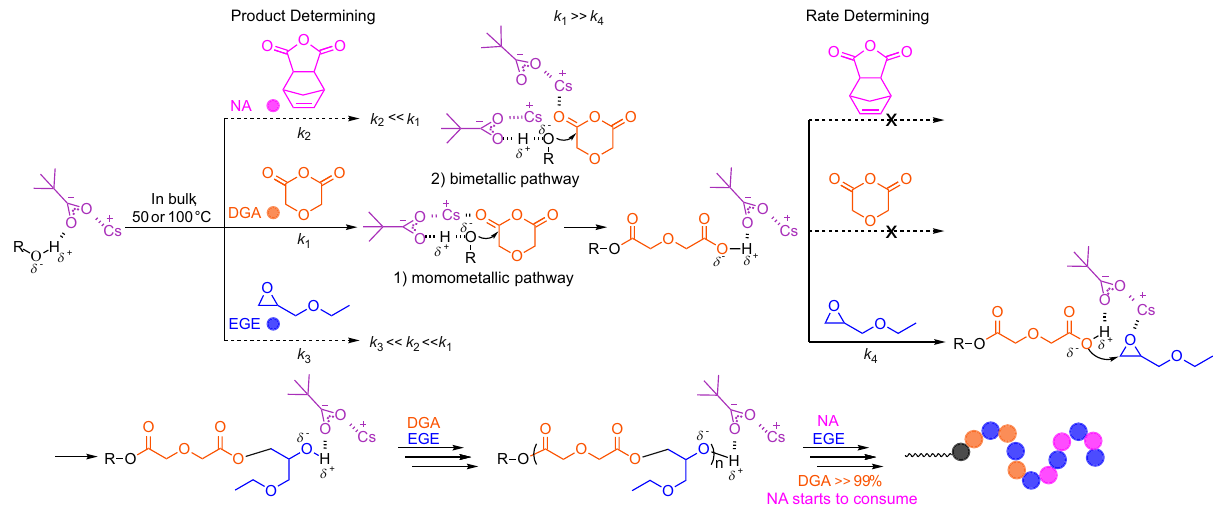
Fig. 2 Proposed mechanism of self-switchable polymerization from a mixture of DGA, NA, and epoxides with cesium pivalate as the catalyst and alcohol as the initiator. Possible mechanism in the ring-opening step includes momometallic pathway and bimetallic pathway. Pink: NA. Orange: DGA. Blue: EGE.